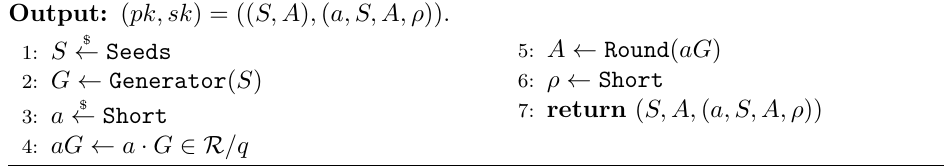
Algorithm 4 NTRU LPRime Key Generation: LPRKeyGen()